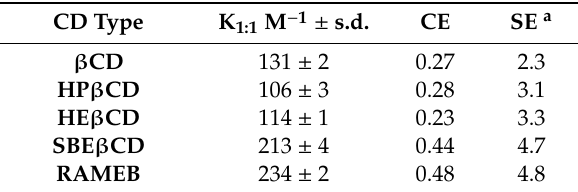
Figure 1. Phase solubility diagrams of HCT with β CD( □ ), HP β CD ( Δ ), HE β CD ( ○ ), SBE β CD (X), and RAMEB ( (cid:7) ). Each value represents the mean of 9 measurements. Table 1. Stability constant (K 1:1 ), complexation efficiency (CE), and solubilizing efficiency (SE) of complexes of the different examined cyclodextrins (CDs) with hydrochlorothiazide in pH 5.5 phosphate buffer at 25 °C.